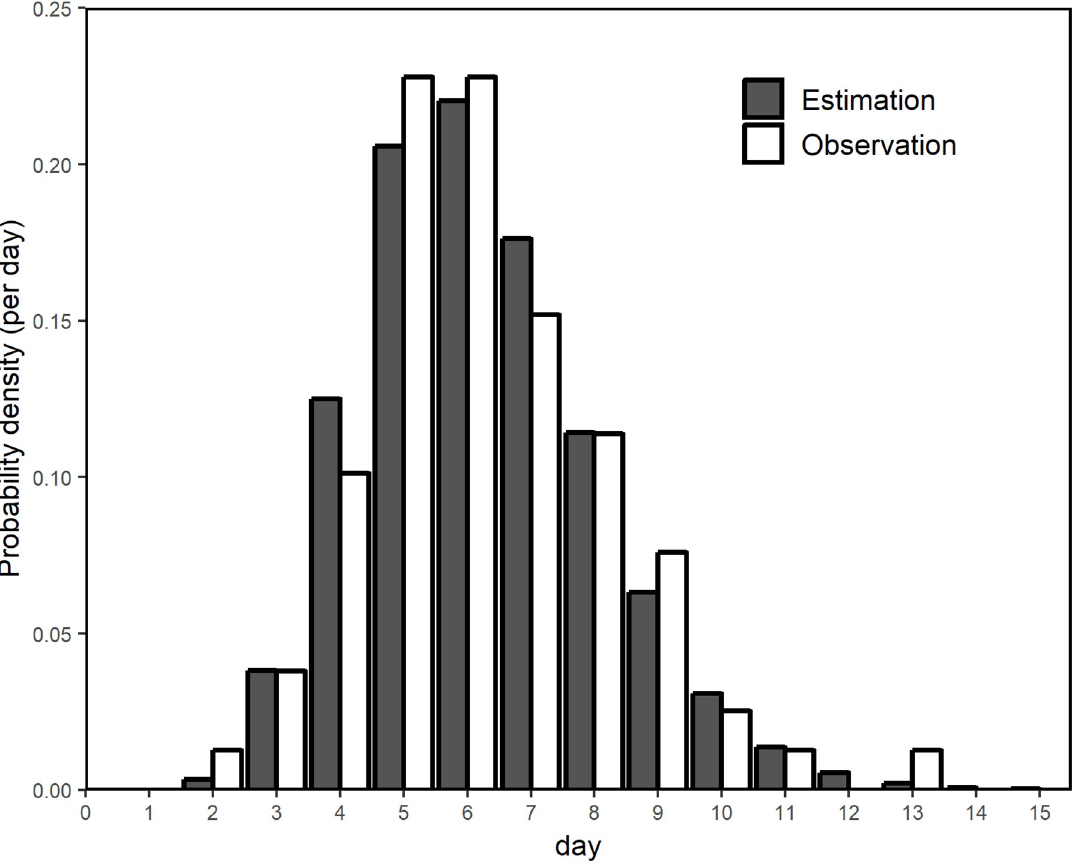
Fig 2. Comparison between observed and estimated distributions of the incubation period. Horizontal axis represents the incubation period of dengue virus infection, i.e., the time from mosquito exposure to illness onset. Grey bars represent observed frequency of the incubation period; white bars represent the estimated probability